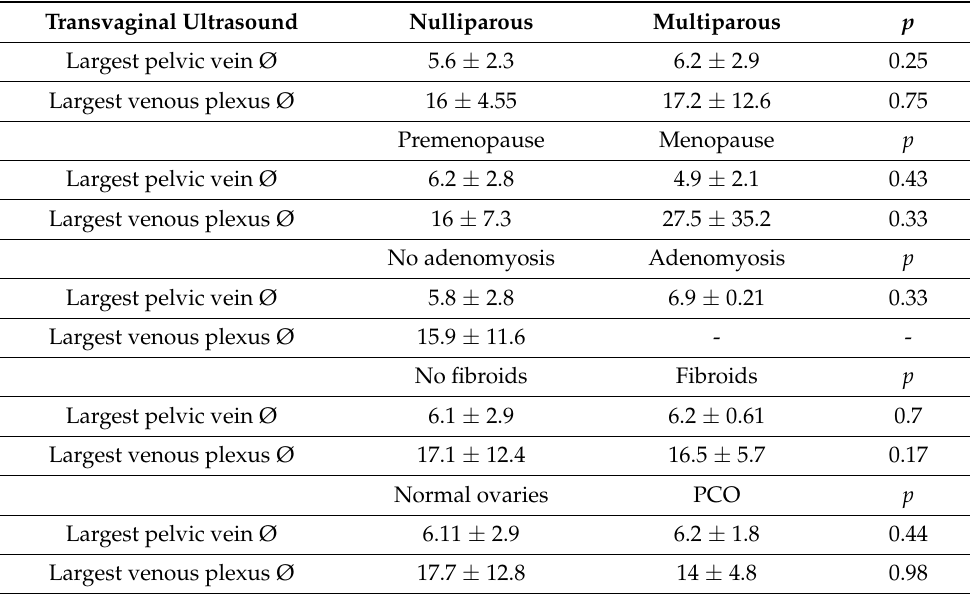
Table 6. Assessment of factors associated with larger diameters of pelvic